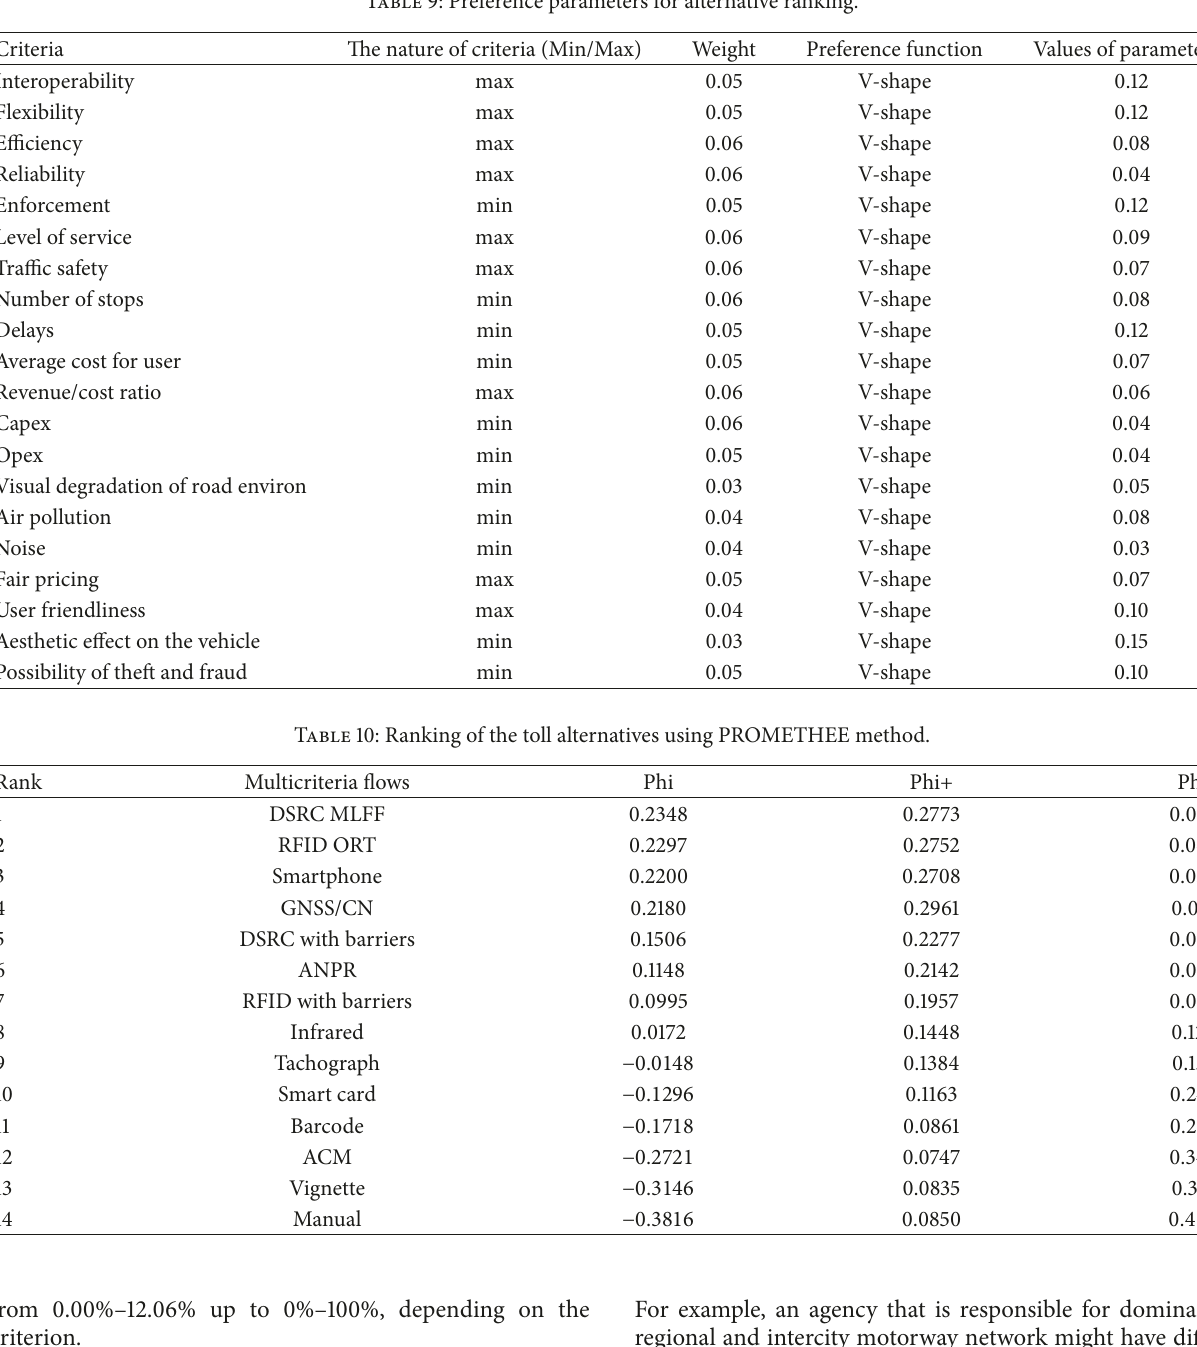
Table 9: Preference parameters for alternative ranking.